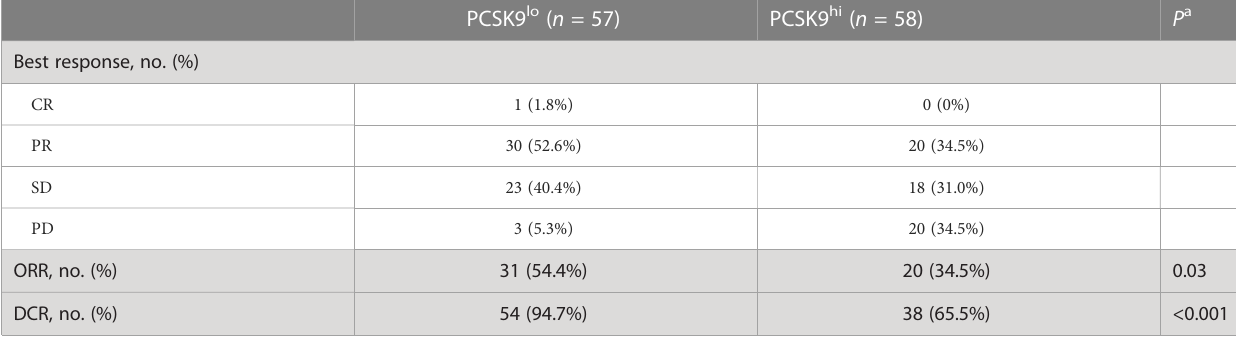
TABLE 2 Best response of advanced NSCLC patients in the PCSK9 lo and PCSK9 hi groups to anti-PD-1 immunotherapy. PCSK9 lo ( n = 57) PCSK9 hi ( n = 58) P a Best response, no. (%)